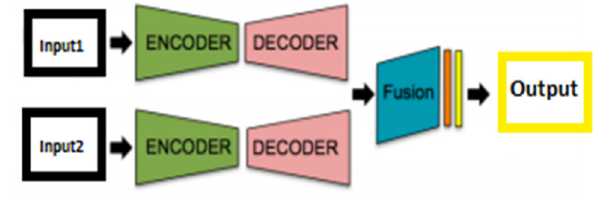
Figure 5. Late fusion architecture.